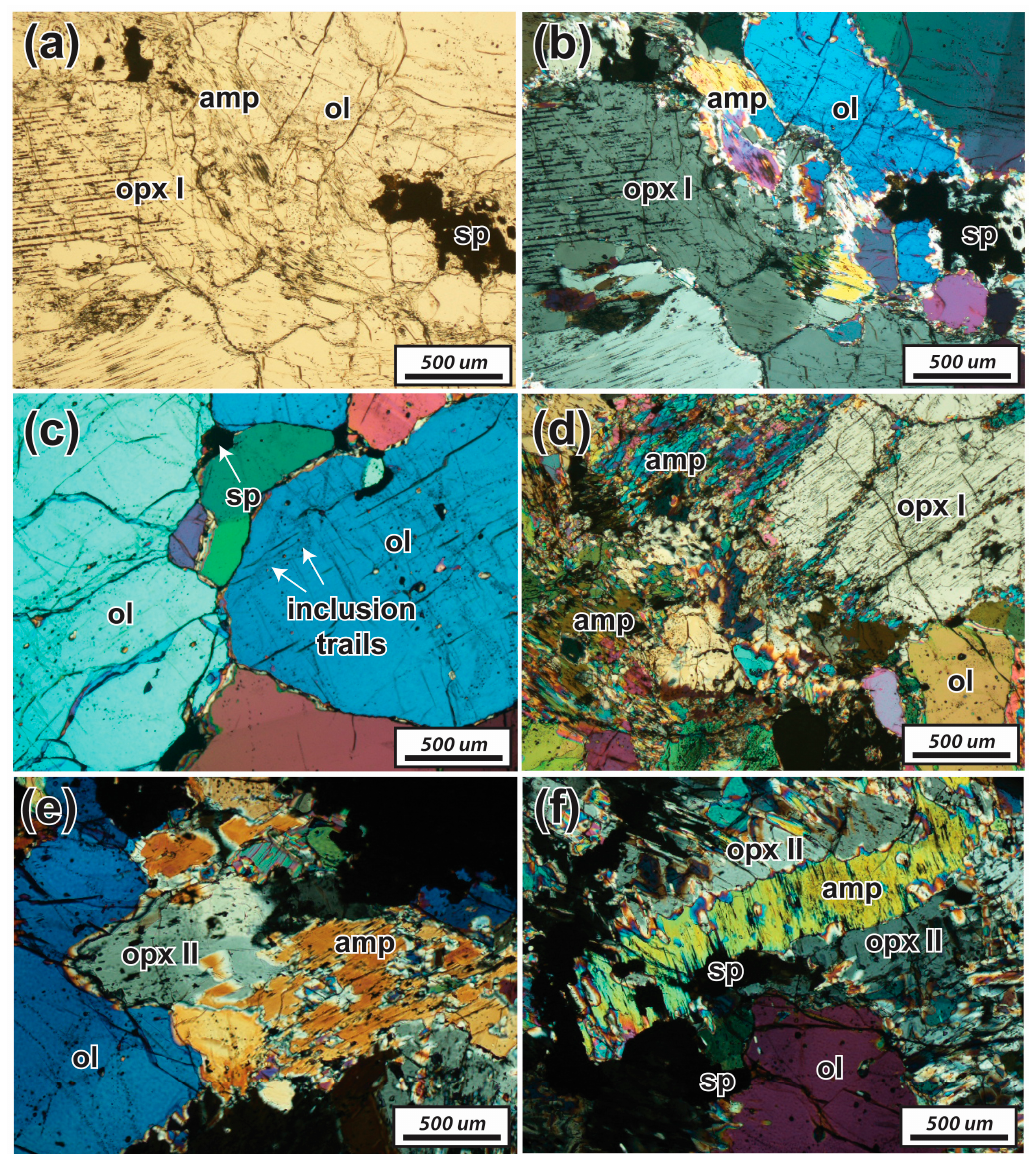
Figure 4. Photomicrographs of the coarse-grained spinel harzburgite xenoliths. ( a , b ) The spinel harzburgite is porphyroclastic and composed mainly of olivine (ol), orthopyroxene (opx I) and spinel (sp). ( c ) Olivine commonly contains numerous fluid inclusion trails. ( d , f ) Fibrous secondary amphibole (amp) and secondary orthopyroxene (opx II) commonly occur in the interstices of the main mineral phases.